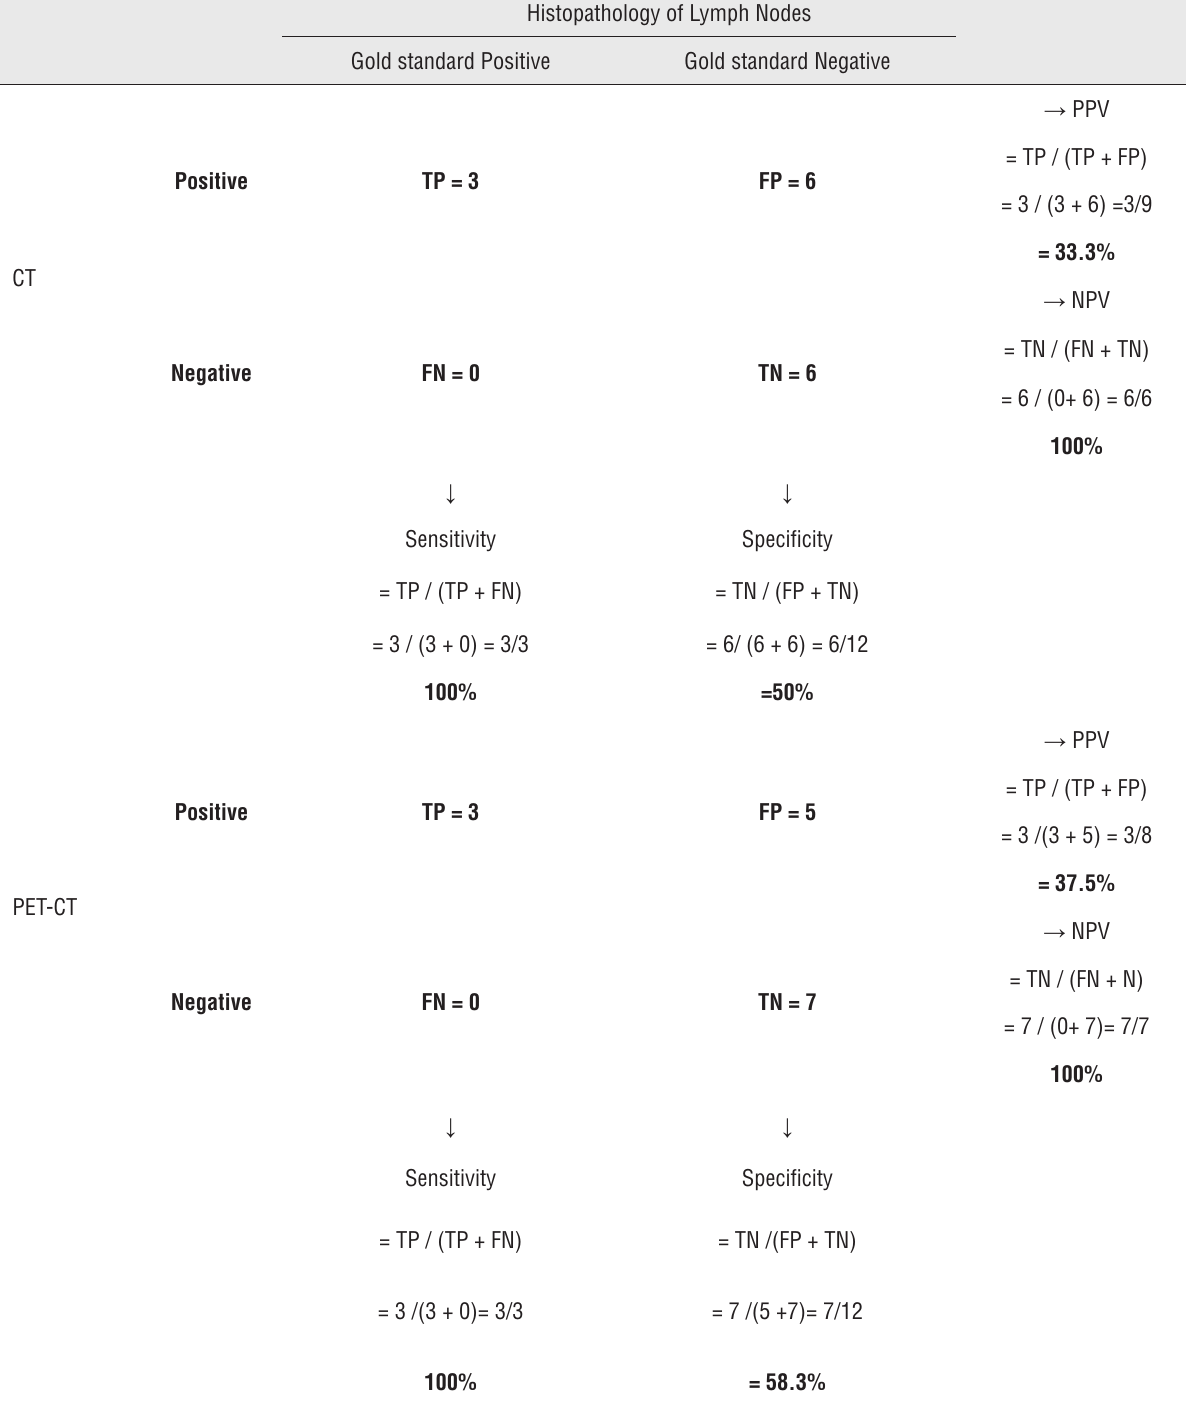
Table 1 - CT and pET-CT accuracy for lymph